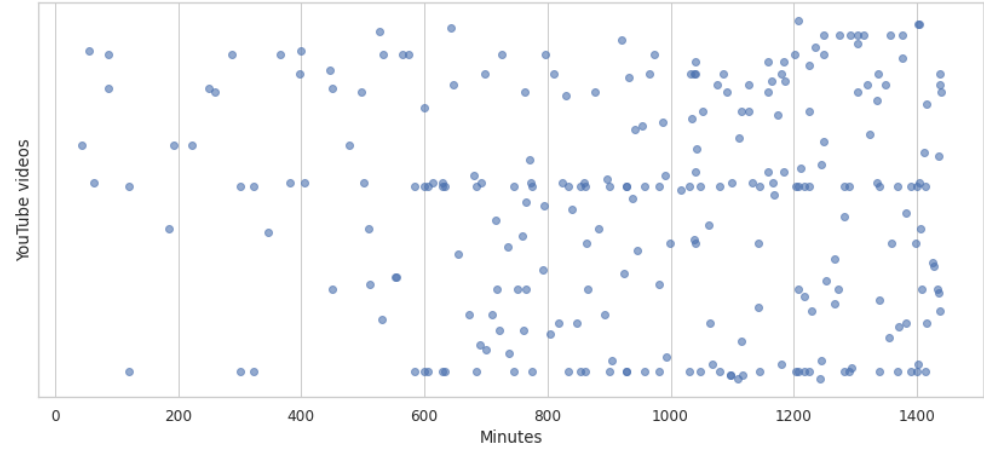
Figure 4. Temporal distribution of BitChute videos.